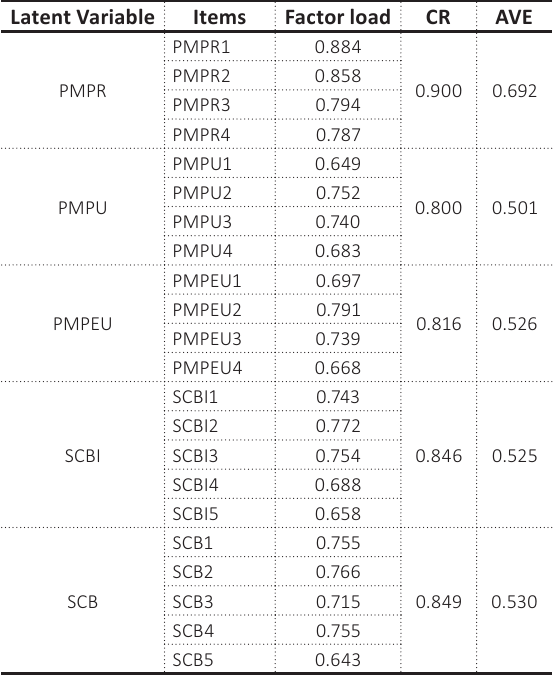
Table 5. Convergence validity